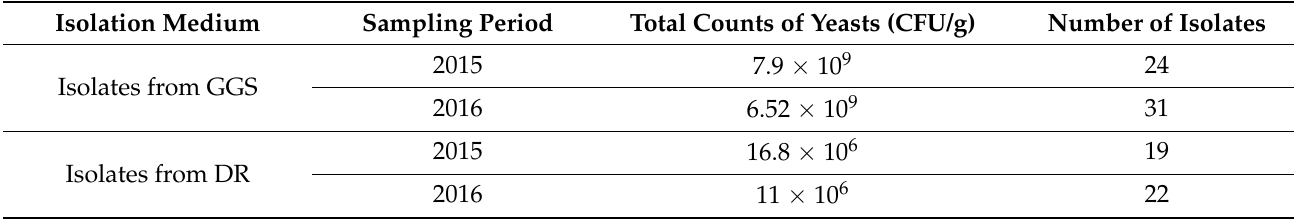
Table 2. Percentage of isolates screened for cellulase activity.